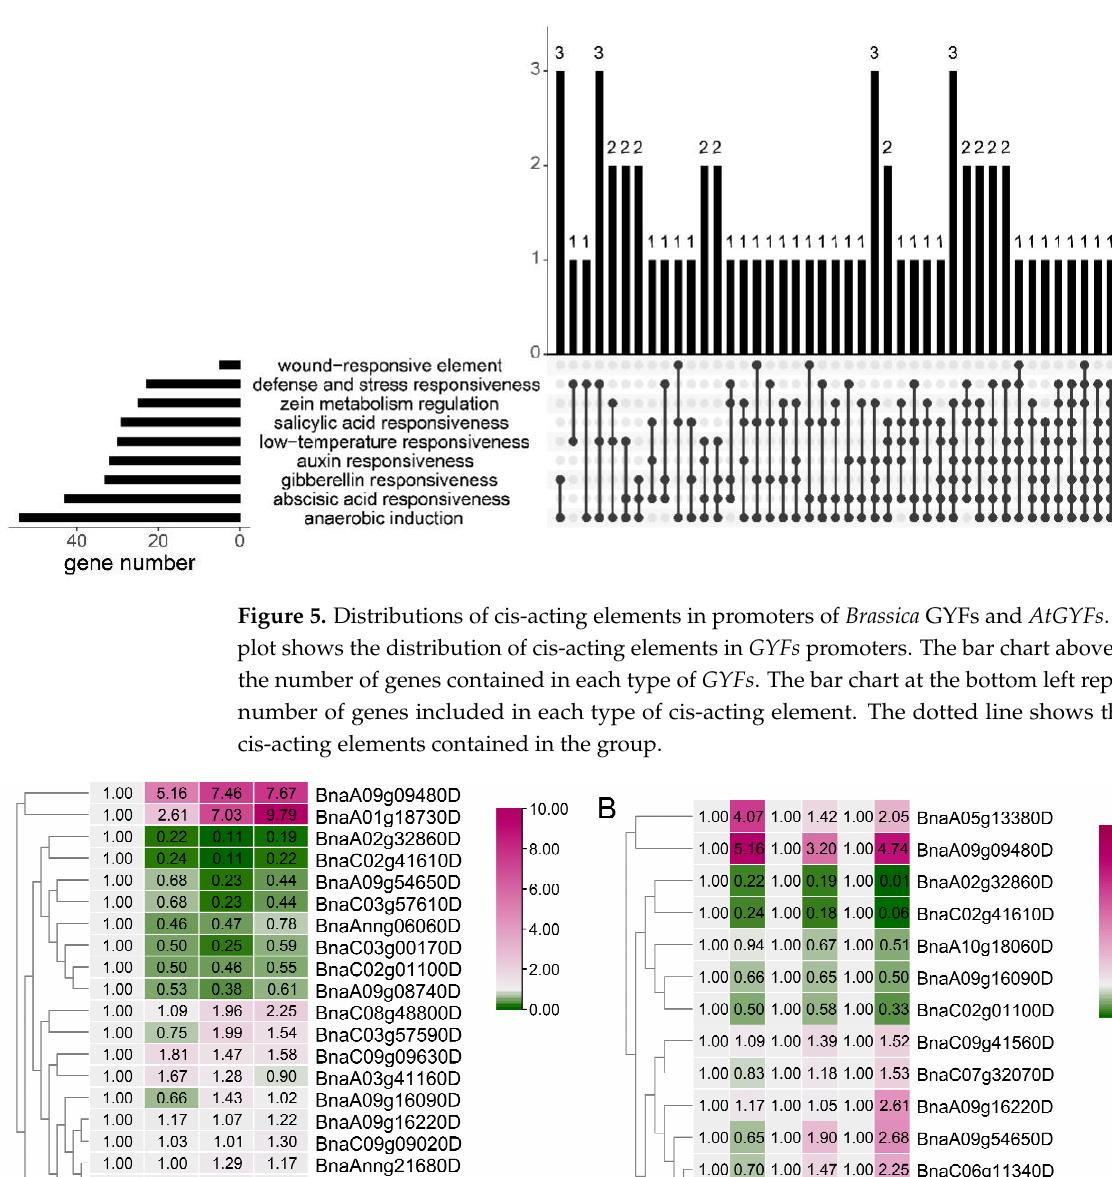
Figure 4. Phylogenetic tree of GYF proteins in B. napus (●), B. rapa , B. oleracea , and A. thaliana . The phylogenetic tree was generated by the NJ method with bootstrap analysis (5,000 bootstrap repli- cates) using an amino acid sequence alignment of GYF proteins from B. napus (●), B. rapa , B. oleracea , and A. thaliana by the MEGA 11.0 program. GYF proteins were divided into 7 groups.